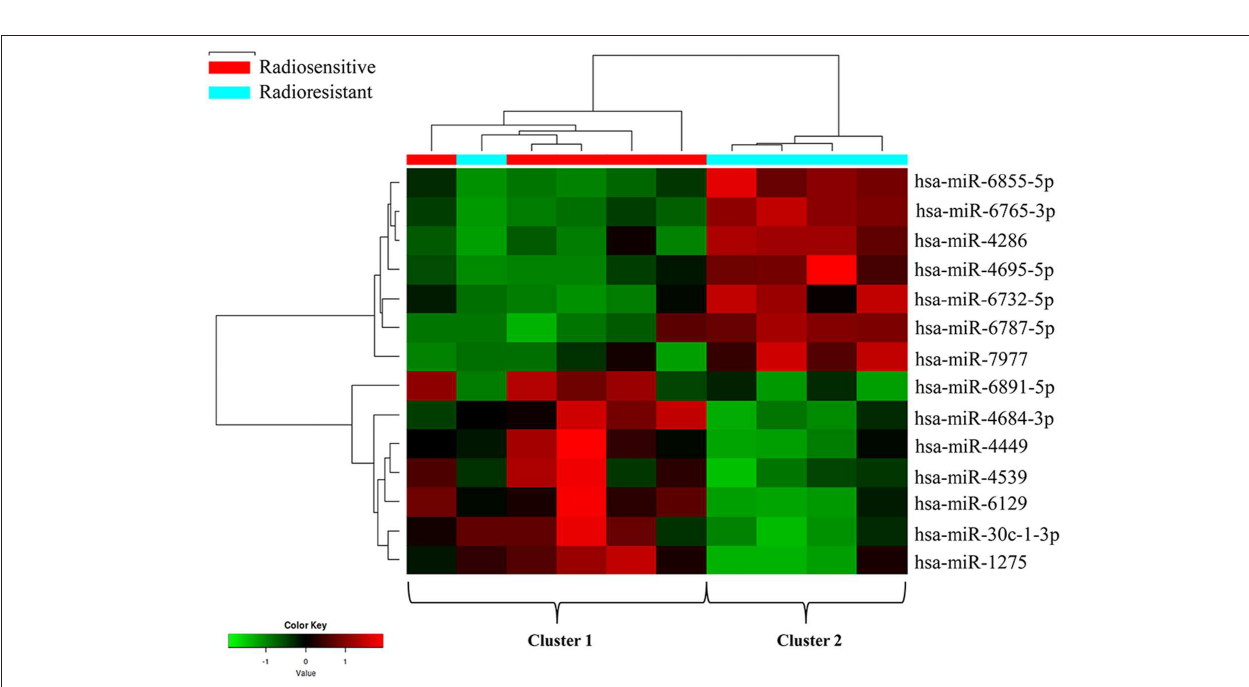
FIGURE 1 | Differential expression microRNAs (miRNAs) in the radiosensitive and radioresistant groups of atypical meningioma with gross total resection plus adjuvant radiotherapy (GTR + ART). (A) Detection levels on Affymetrix microarrays of the microRNAs in radioresistant group ( gray ) and radiosensitive group ( black ). Detection intensities correspond to the measured values minus the threshold value. (B) The ratios of the measured intensities of microRNAs detected in radioresistant group vs. the intensities in radiosensitive group. The ratios are shown on a log 2 scale.